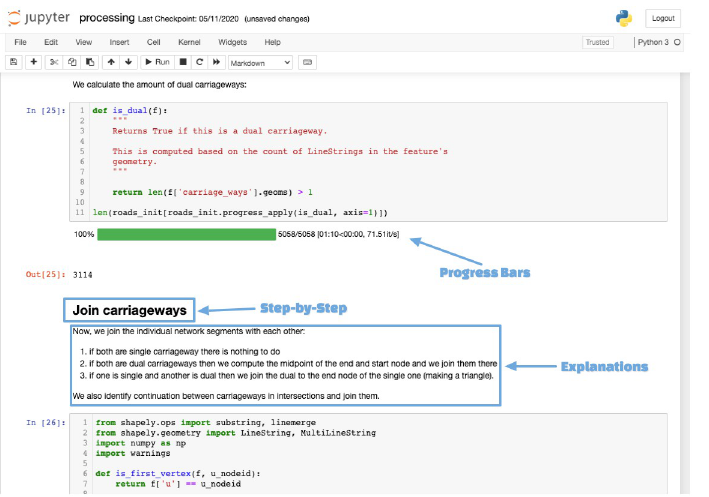
Fig 10. View of the Jupyter output while running the